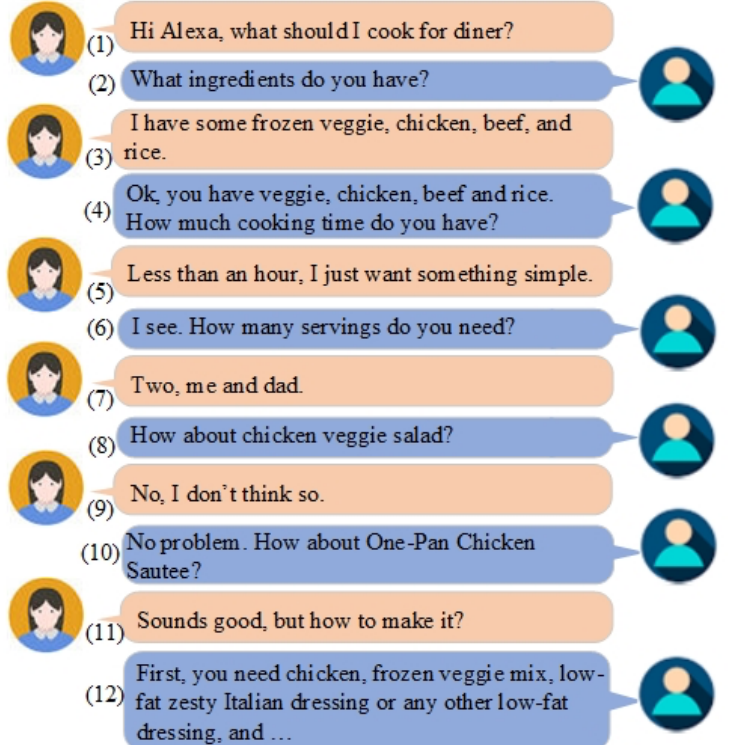
Figure 5. An example fragment of a conversation between the user and the voice assistant about meal recipe